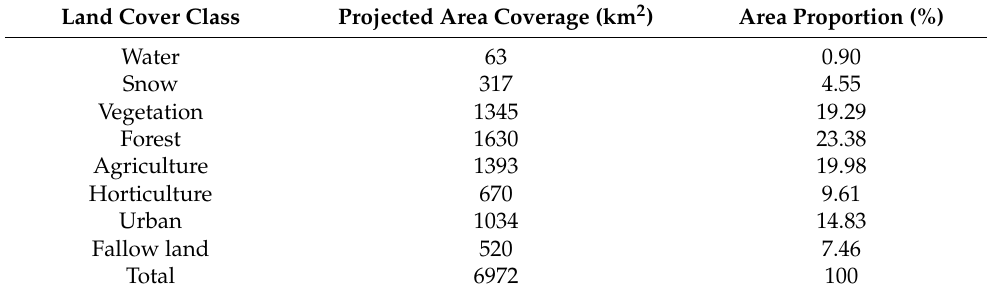
Table 11. Projection of LULC of the area in